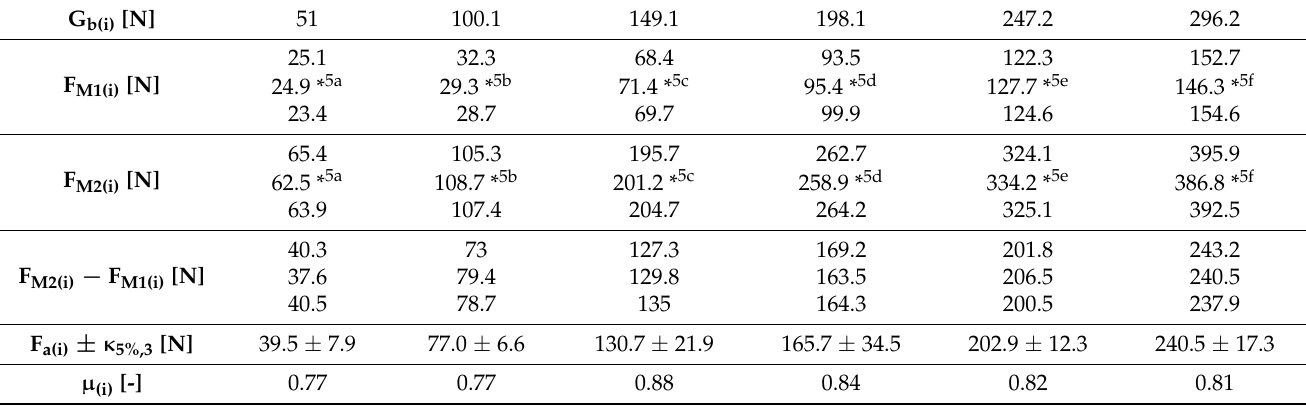
Table 6. Measured force F M1(i) [N] and F M2(i) [N] for the weight of the load G b(i) [N] at angle β = 40 deg.